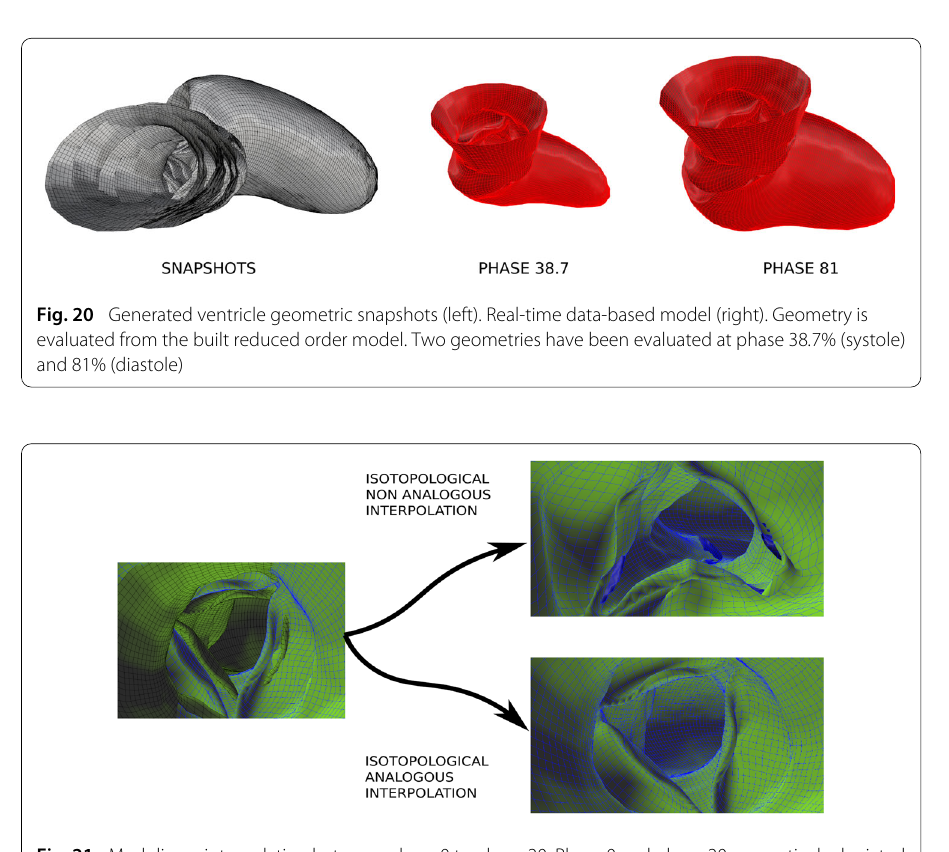
Fig. 21 Mesh linear interpolation between phase 0 to phase 20. Phase 0 and phase 20, respectively depicted in black and blue (left). Isotopological non-analogous meshes yield non-consistent interpolated mesh with intersections (right) whereas analogous ones gives the expected result